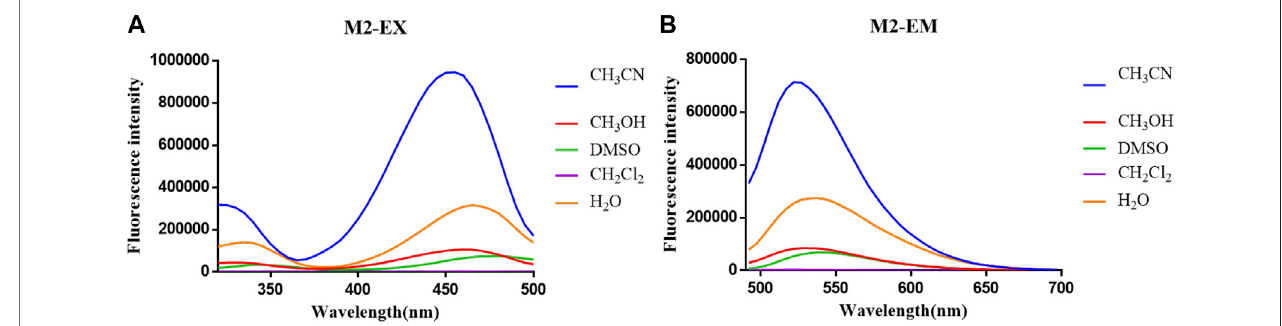
FIGURE 2 | (A) Fluorescent excitation and (B) emission spectra of probe M1 in different solvents.